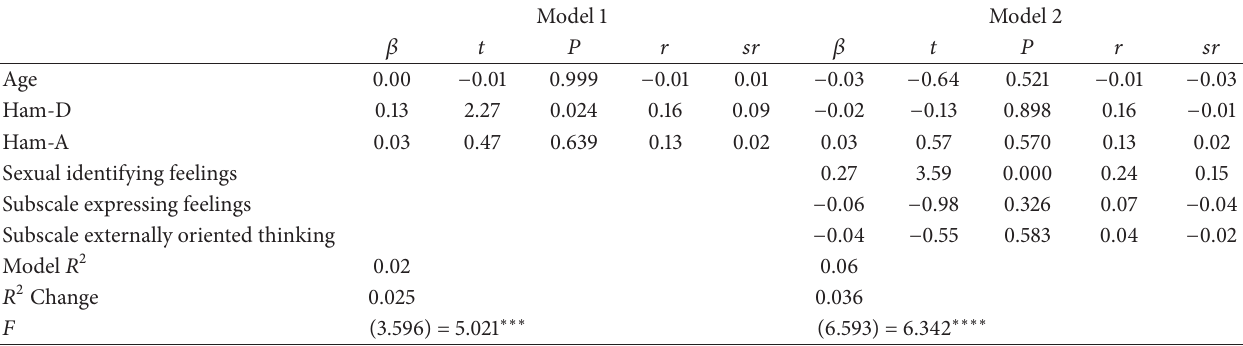
Table 5: Hierarchical multiple regression analyses predicting IA severity scores from alexithymia scores controlling for negative emotions and